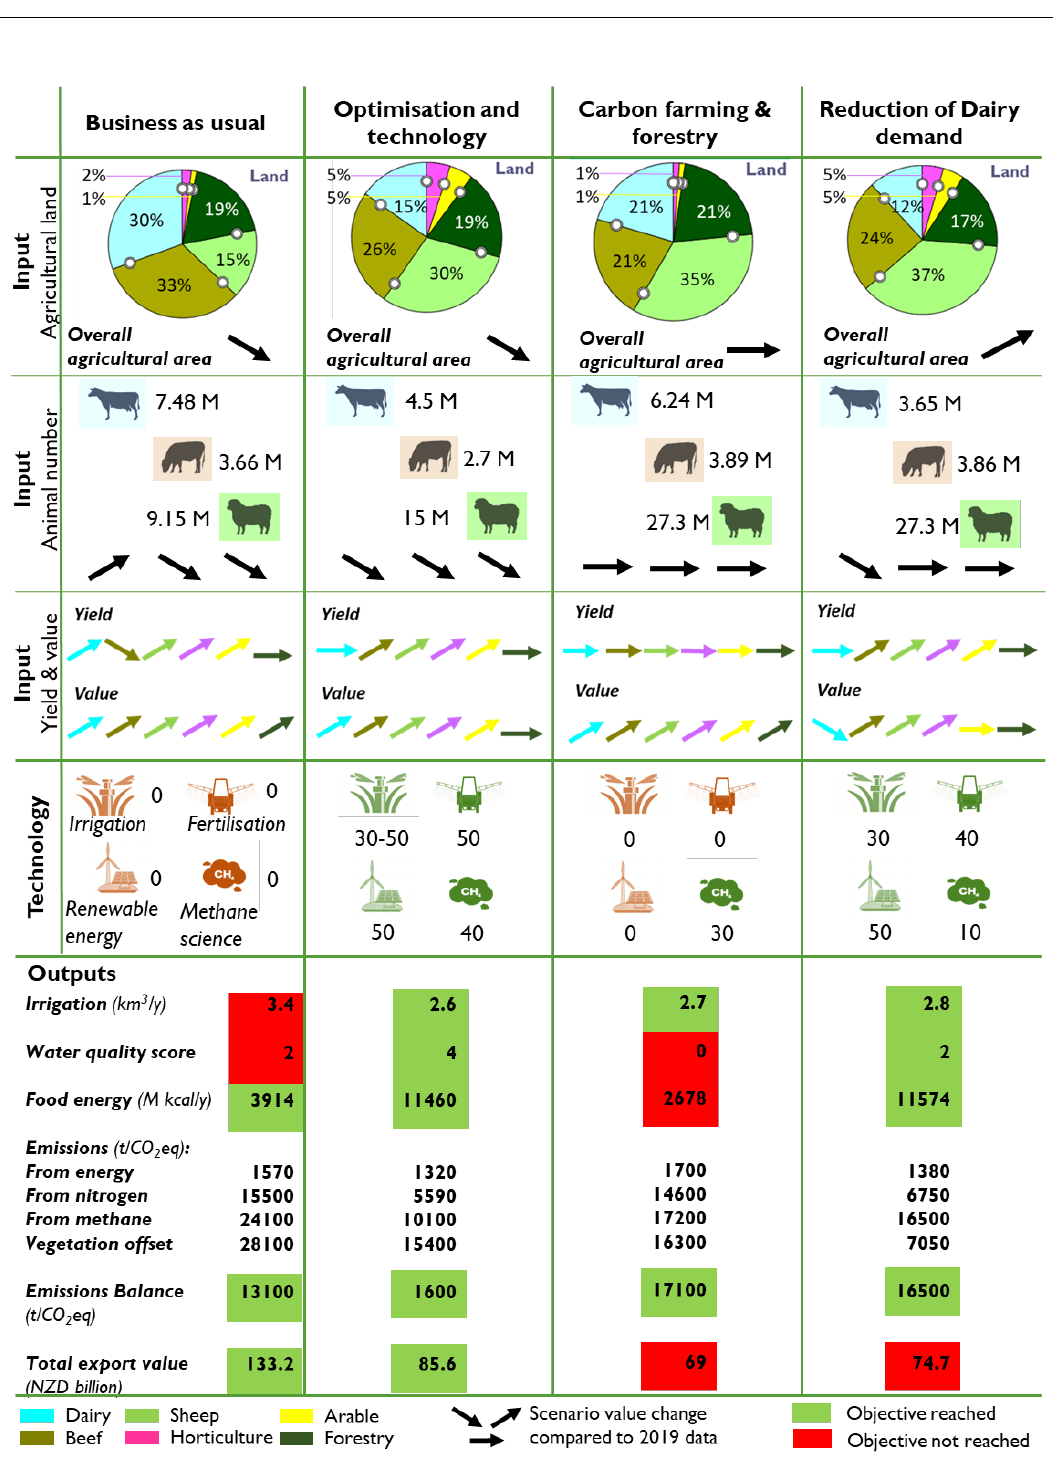
Figure 5. Results of example simulations as described in the